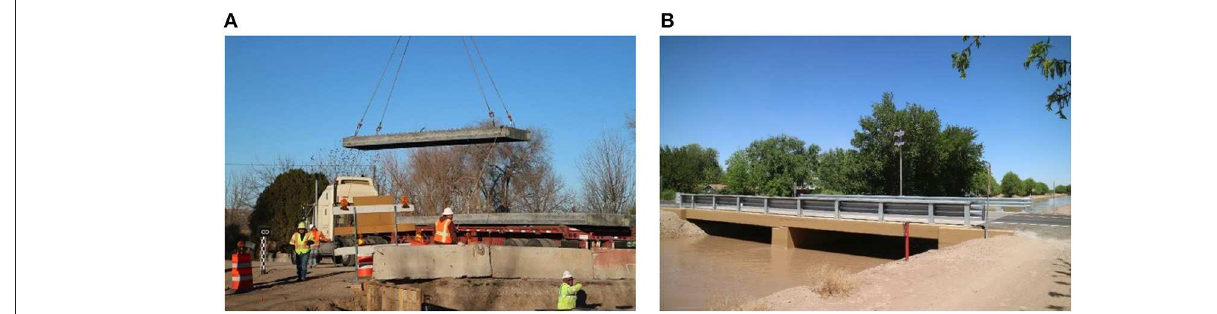
FIGURE 1 | Bridge 9706 (A) during construction, (B) at completion.